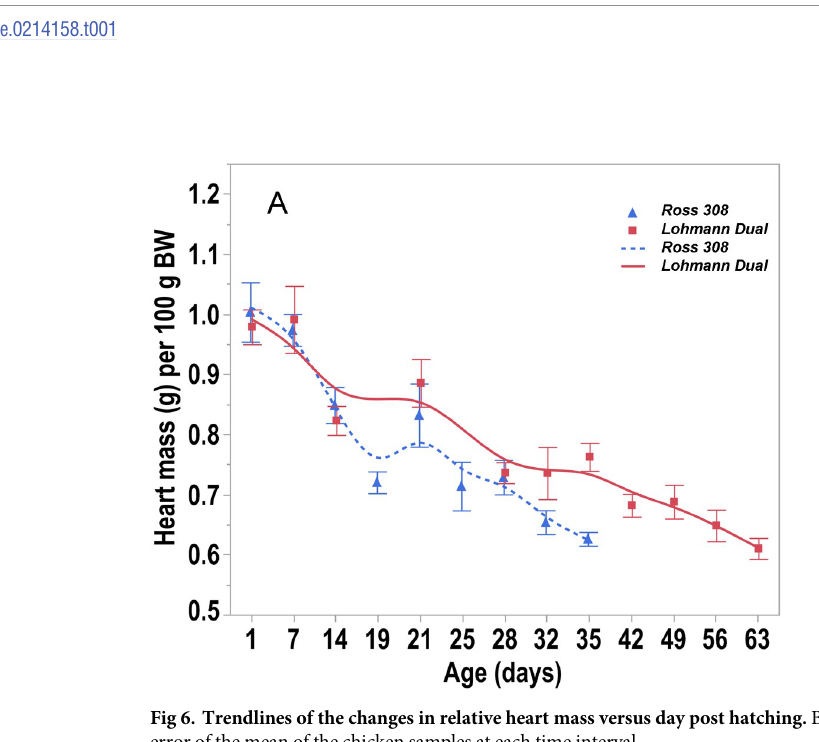
PLOS ONE | https://doi.org/10.1371/journal.pone.0214158 March 21,